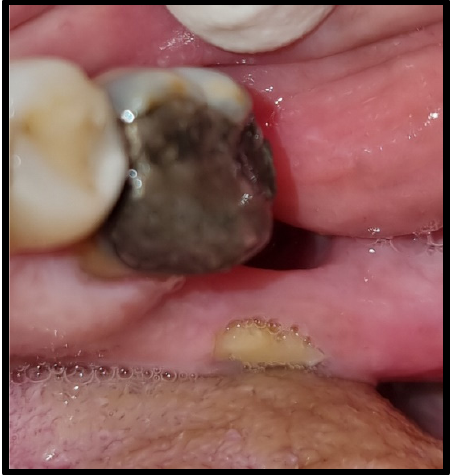
Figure 7. MRONJ, right lingual mandible. The patient, on atezolizumab and zoledronic acid and